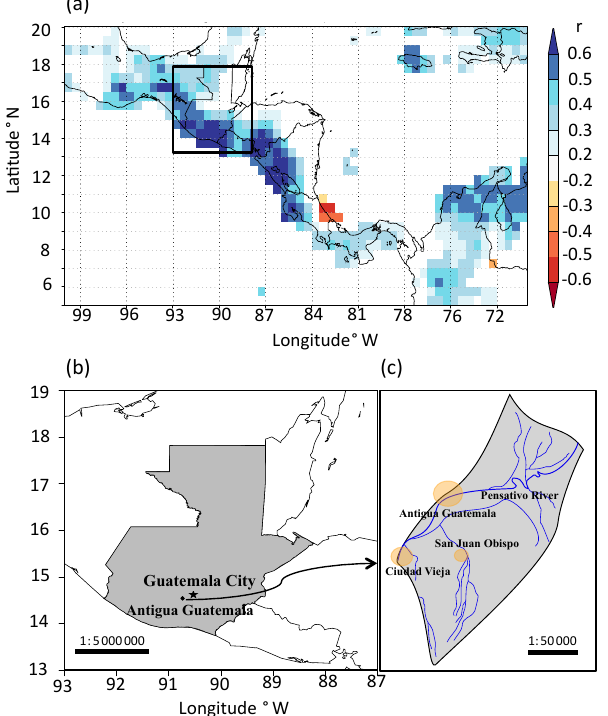
Figure 1. (a) Spatial correlation between the Guatemala City Ob- servatory precipitation record (INSIVUMEH, 1928–2012) and grid- ded precipitation across Central America (GPCC V7 reconstruc- tion database; grid size 0.5 ◦ ; Schneider et al., 2015) averaged for the May–October period and plotted according to the strength of the correlation coefficient. (b) Map of present-day Republic of Guatemala and location of the cities of Antigua Guatemala (San- tiago de Guatemala) and Guatemala City (Nueva Guatemala de la Asunción). (c) Map of the Pensativo River catchment relative to the city of Antigua Guatemala and the towns of Ciudad Vieja and San Juan